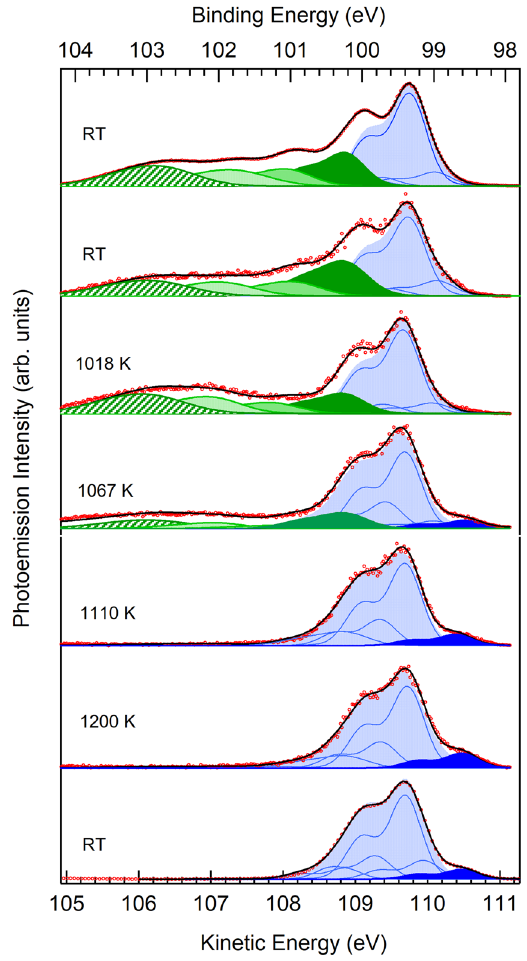
Figure 3. Selected spectra measured during the oxide layer desorption corresponding to the heating schedule ( v av = 2.5 K.s − 1 ). The top and bottom spectra were acquired in sweep mode at room temperature. They correspond to the initial surface (1.4 ML of oxygen deposited at room temperature) exhibiting the contribution of the four oxidation states at higher binding energy (from dark green Si 1 + to hatched green Si 4 + ) than that of the bulk elemental silicon component (light blue shaded) and to the de-oxidized surface, where the restatom (RA) surface states (at lower binding energy than the bulk line, dark blue shaded) are clearly apparent. Intermediate panels are spectra measured in time resolved mode (the so-called snapshot mode, the spectra are corrected from detector distortions) along with their corresponding spectral reconstruction. At 1067 K the component shifted by − 0.9 eV from the main elemental Si component (dark green shaded) is due to two contributions, the Si 1 + oxidation state, and a clean surface state (see text). Note the increase in RA intensity from 1110 K to 1200 K (7 × 7 to “1 × 1”